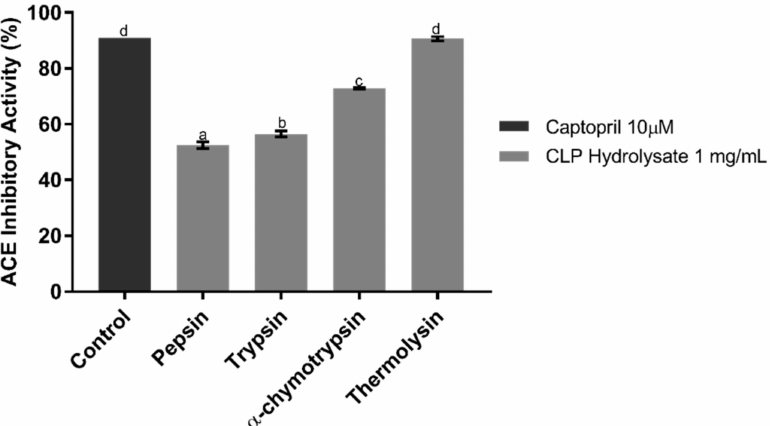
Figure 1. Angiotensin-I converting enzyme (ACE) inhibitory activities of Caulerpa lentillifera protein (CLP) hydrolysates digested by different enzymes. Each point is the mean of three determinations ( n = 3) ± SD. Different letters labeled on the bar indicate significant difference. The concentration of each hydrolysate is 1 mg/mL, and Captopril (10 µ M) is used as positive